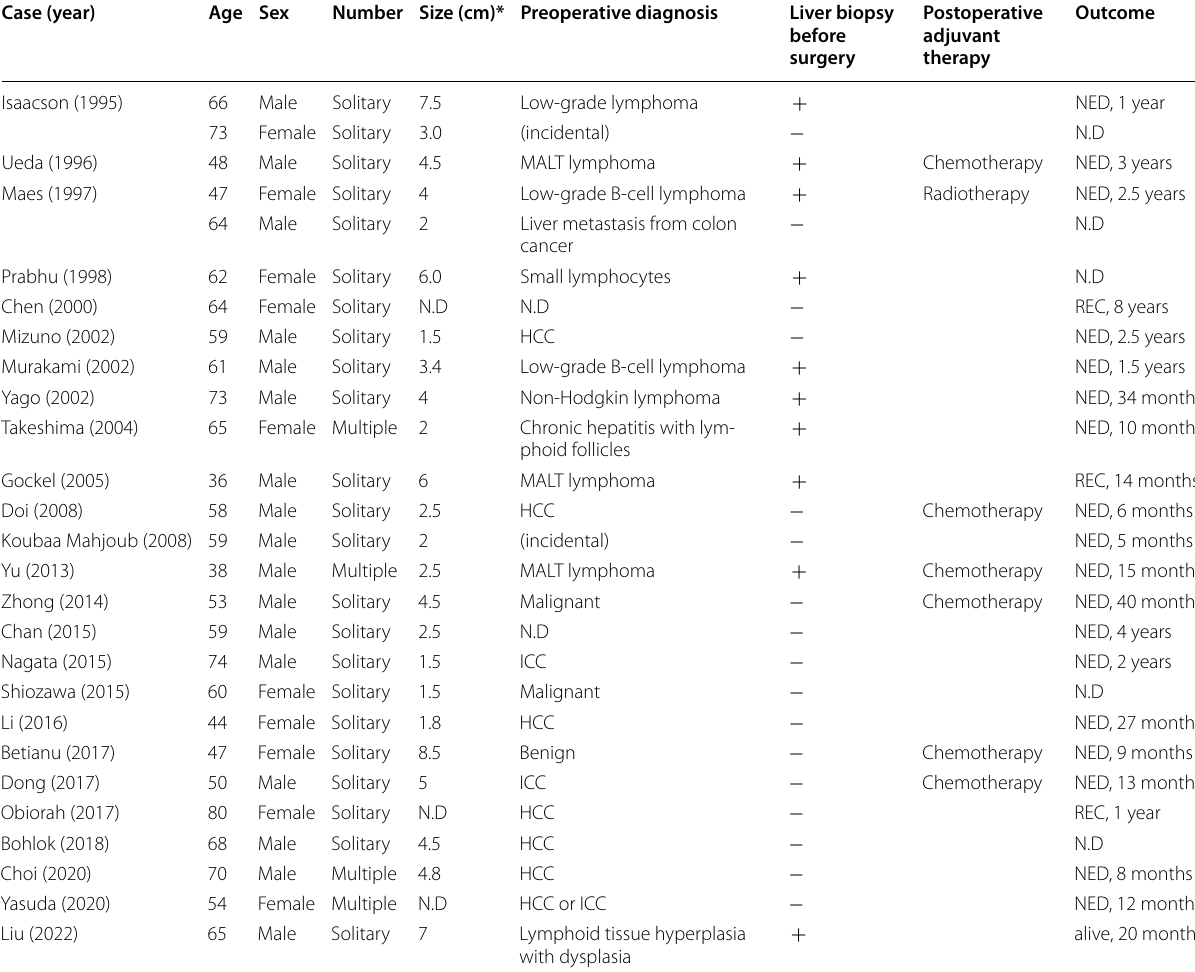
Table 3 Reported case reports of the patients with primary hepatic MALT lymphoma treated by